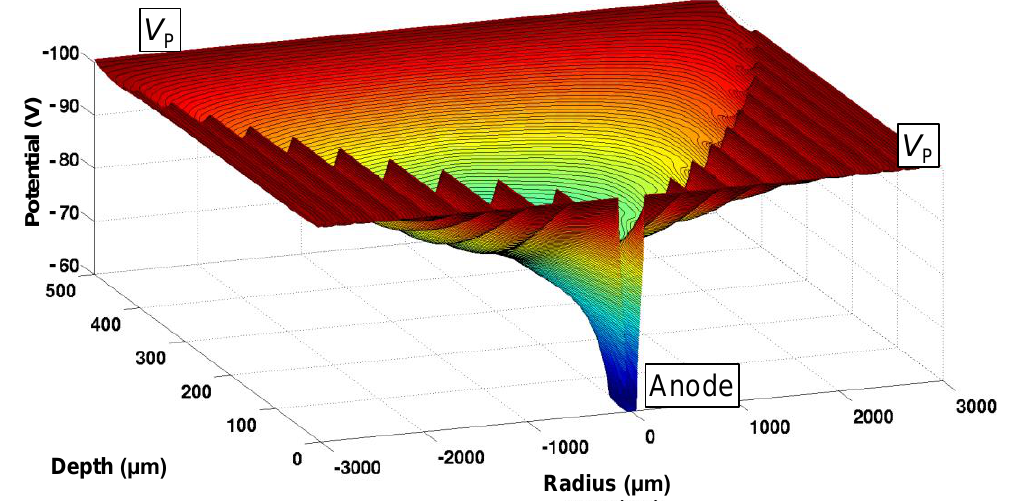
Figure 5. Potential distribution for a TDD with trench parameters optimized to give a fully-depleted drift region without potential wells: n = 12, d n = 50 µm, Δ w sep = 30 µm, N D = 5 × 10 11 cm −3 , and V p = −100 V.